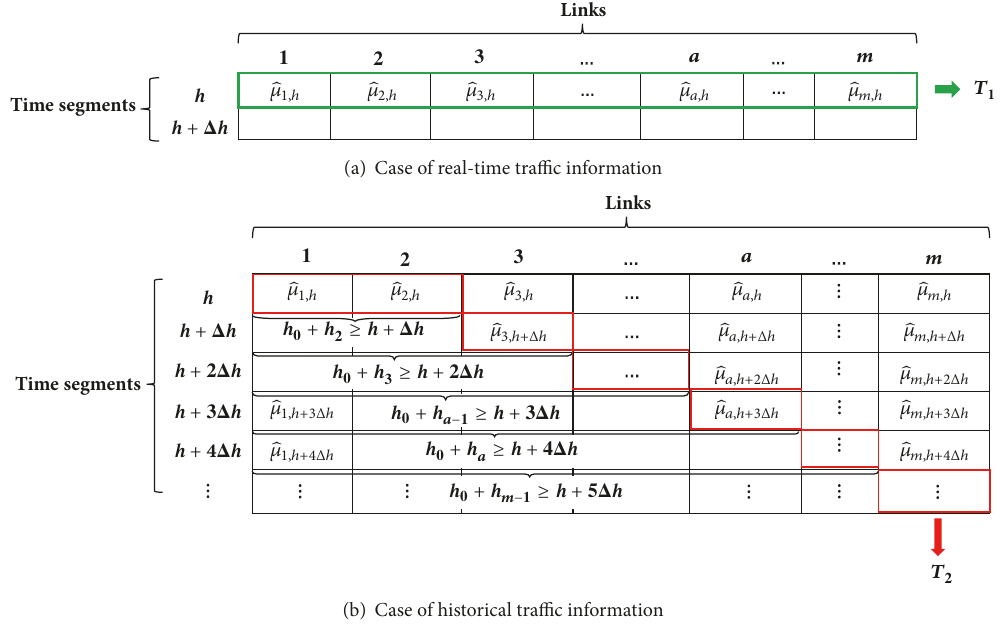
Figure 6: Use of two types of traffic information in